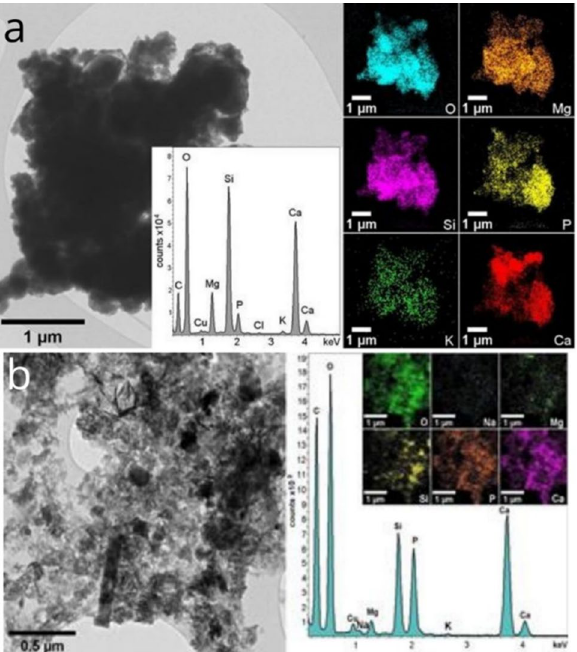
Figure 4. TEM Bright-field images and the EDS data of the: ( a ) BG-Carb sample before immersion in SBF, and ( b ) after 72 h of immersion in SBF. For each sample, the elemental distribution maps are shown on the right- hand side. The Cu signal in EDS spectra arises from the Cu-TEM grid.